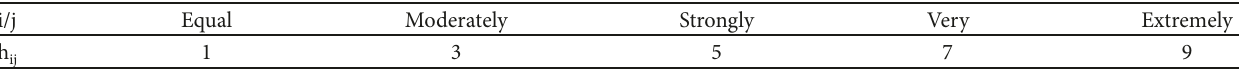
Table 3: Comparison table.